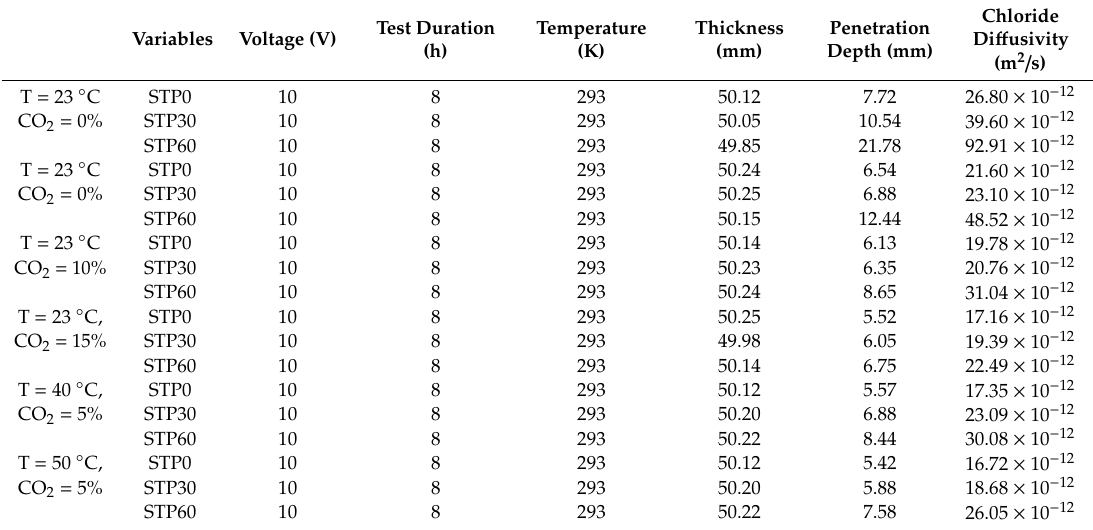
Table 4. Chloride di ff usivity according to the curing conditions.